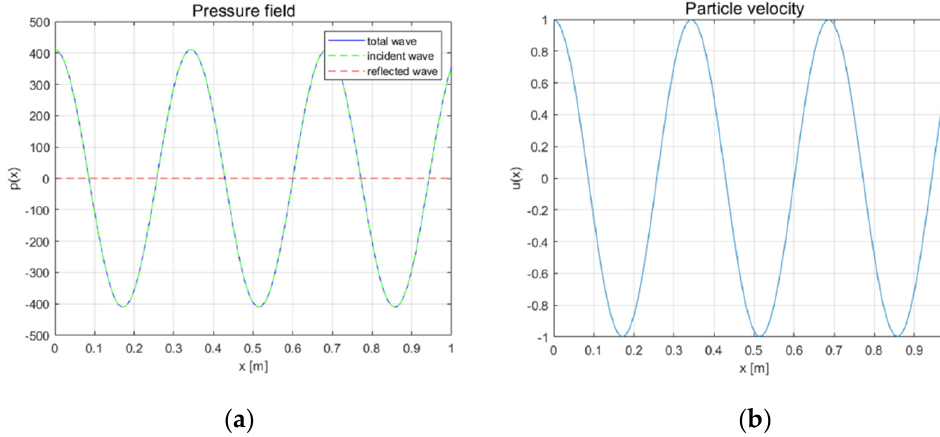
Figure 4. Closed–closed duct with control law maximising the absorption coefficient as boundary condition in the 2D MATLAB model: ( a ) real part of the pressure field in Pascal and ( b ) real part of the particle velocity field at f = 1000 Hz in m/s.